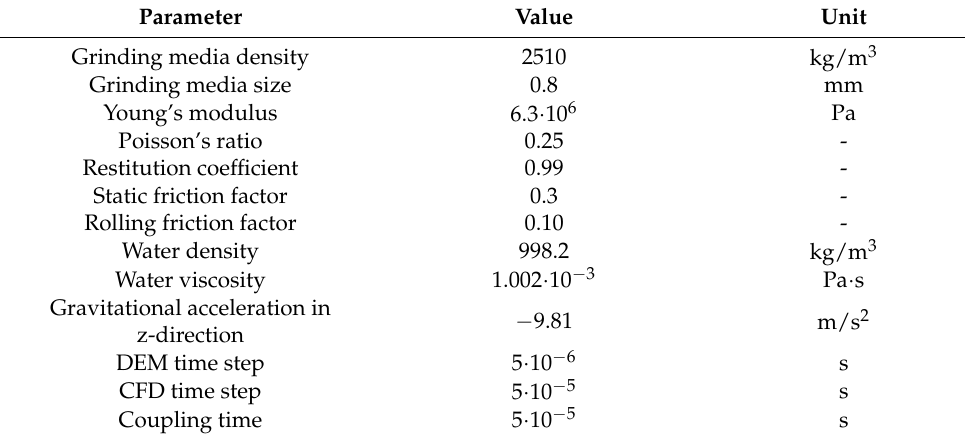
Table 1. Material and simulation parameters.